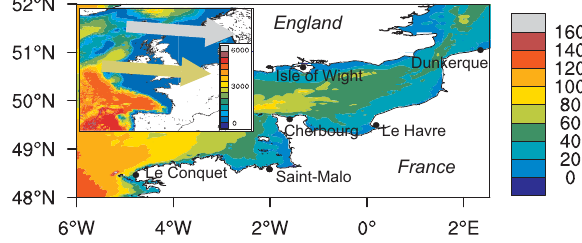
Fig. 1. Bathymetry (m) and study site location. The inset shows the model domain and charts the tracks of the studied depressions (grey: 8–9 November 2007; green: 9–10 March 2008).